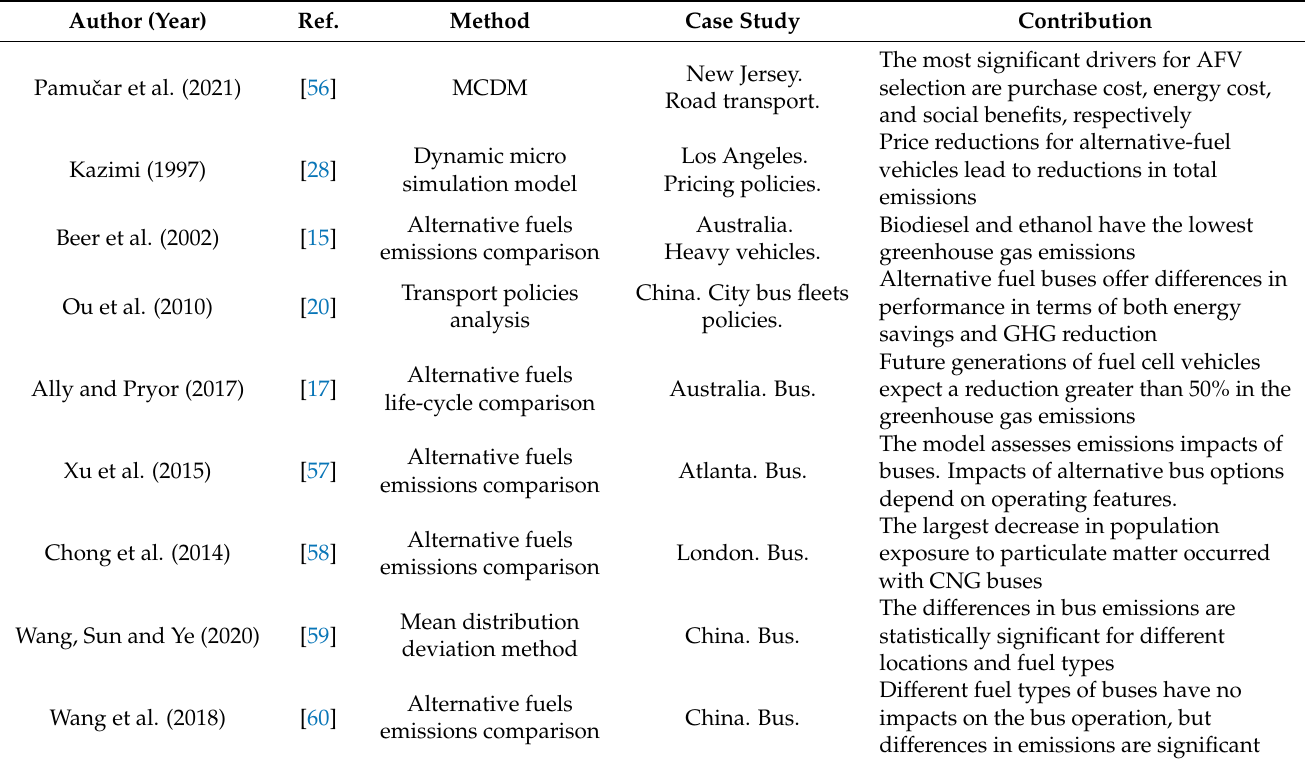
Table 2. Literature review on the emissions assessment of alternative fuel